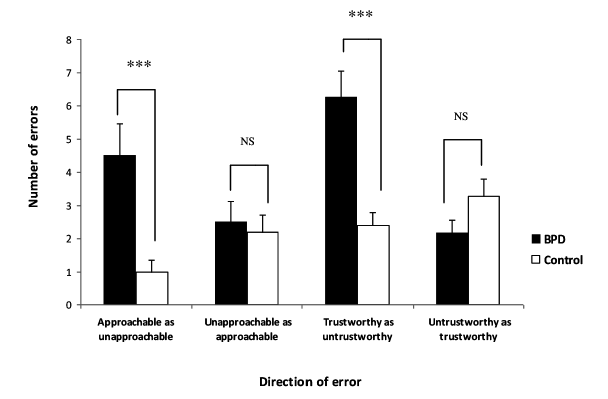
Figure 2. Graph showing the direction of judgement bias for approachability and trustworthiness. The BPD group judged significantly more people as unapproachable and untrustworthy than the control